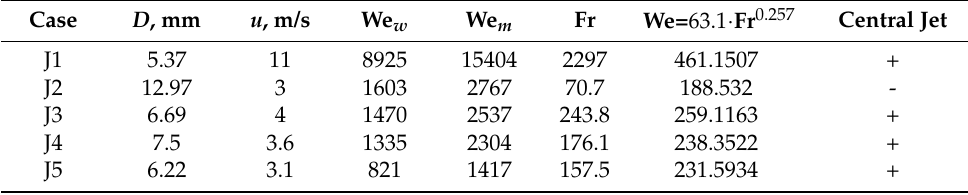
Table 5. Non-dimensional parameters of the jet impact